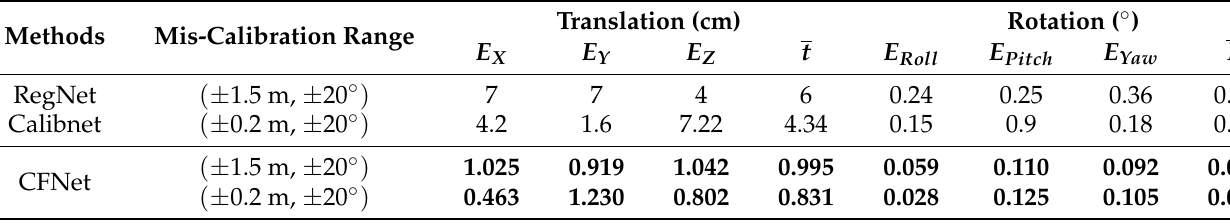
Table 3. The comparison results on the T1 test dataset.